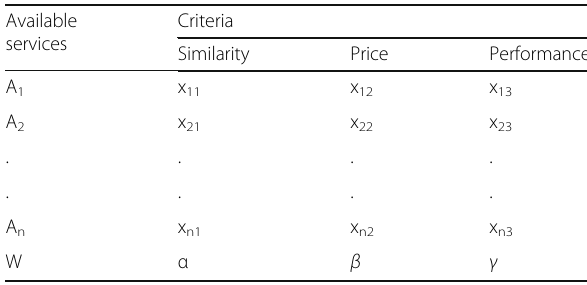
Table 1 Information table of topsis Available services